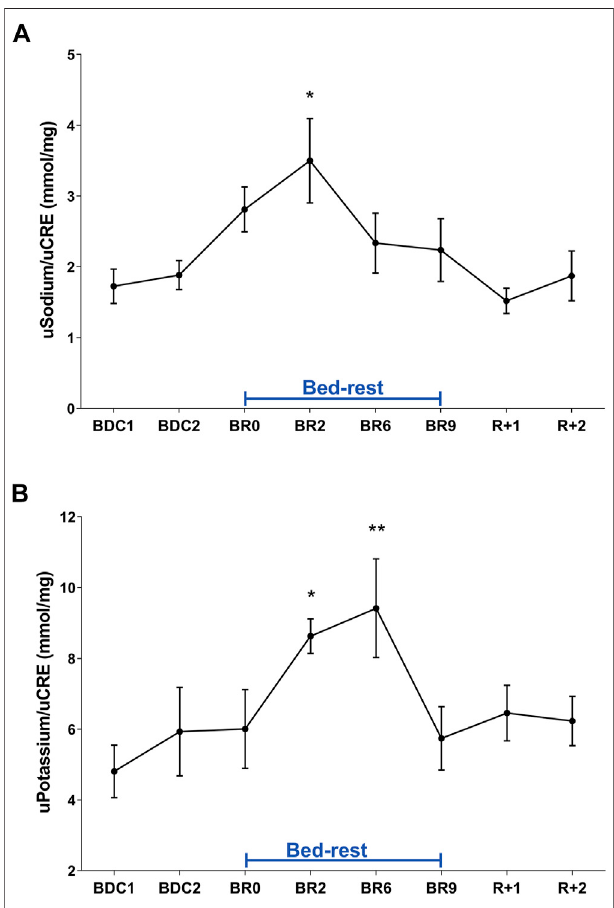
FIGURE 2 | (A) Urinary Sodium excretion normalized to Creatinuria (mmol/mg) during 10-day bedrest. Data are expressed as mean ± S.E.M. StatisticalanalysiswasdoneusingOrdinaryone-wayAnovatest(* p < 0.05for BR2 vs. BDC1); (B) urinary Potassium excretion normalized to Creatinuria (mmol/mg) during 10-day bedrest. Data are expressed as mean ± S.E.M. Statistical analysis was done using Ordinary one-way Anova test (* p < 0.05 for BR2 vs. BDC1; ** p < 0.01 for BR6 vs. BDC1).